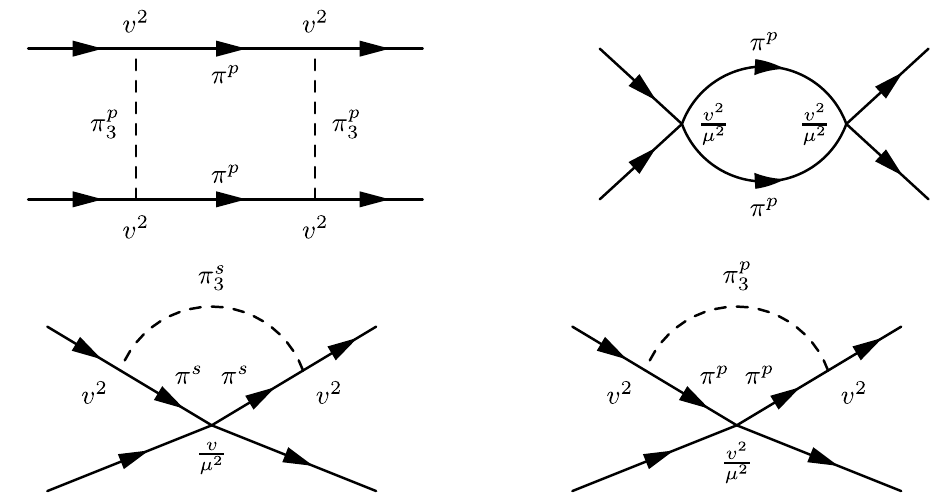
Figure 3 . Leading loop topologies which correct the contact interaction in ππ scattering. The scaling of vertices and the modes in the loop are